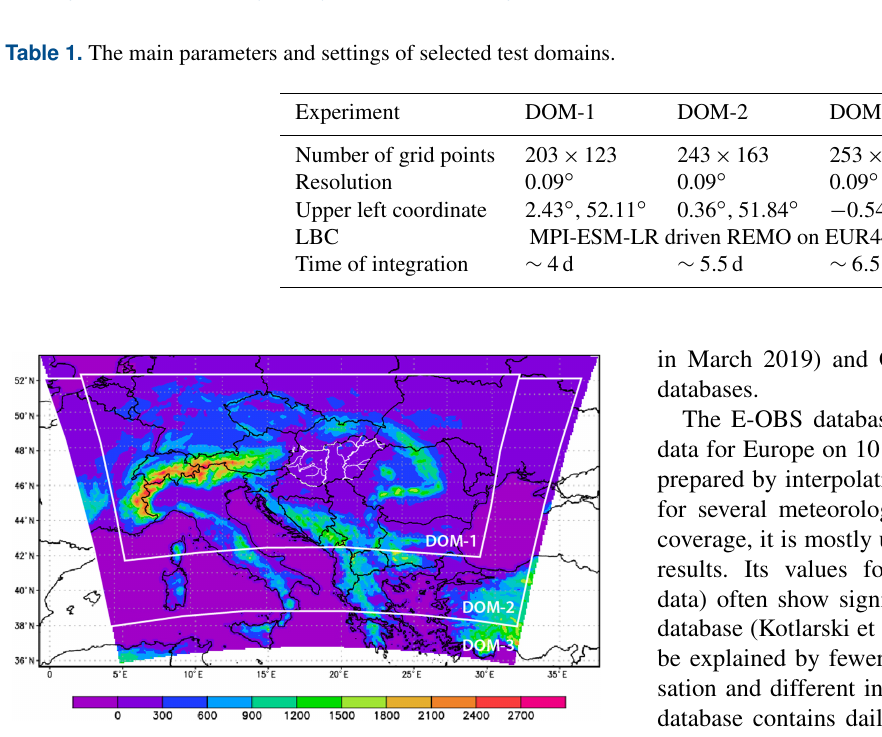
Figure 1. Area and topography of the three selected model domains (altitude above sea level, m). For Hungary the rivers and lakes are indicated with white